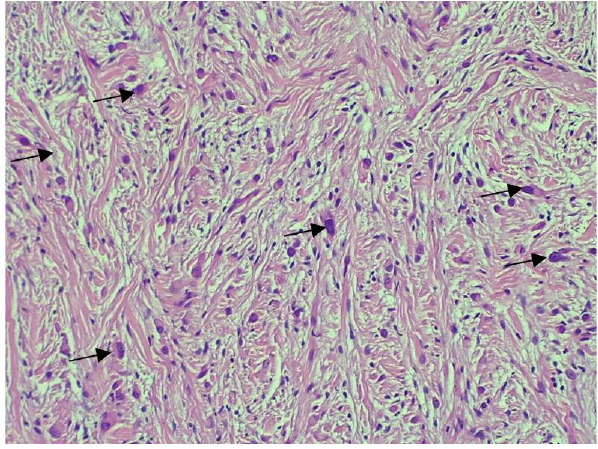
Figure 5. Tumoural proliferation with fusiform cells and myxoid stroma that infiltrate the myocardial fibres and mild degree of nuclear atypia.